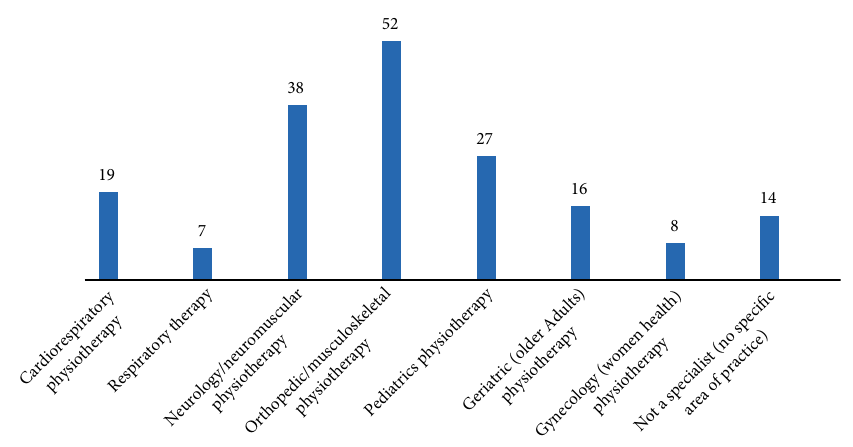
Figure 2: Type of